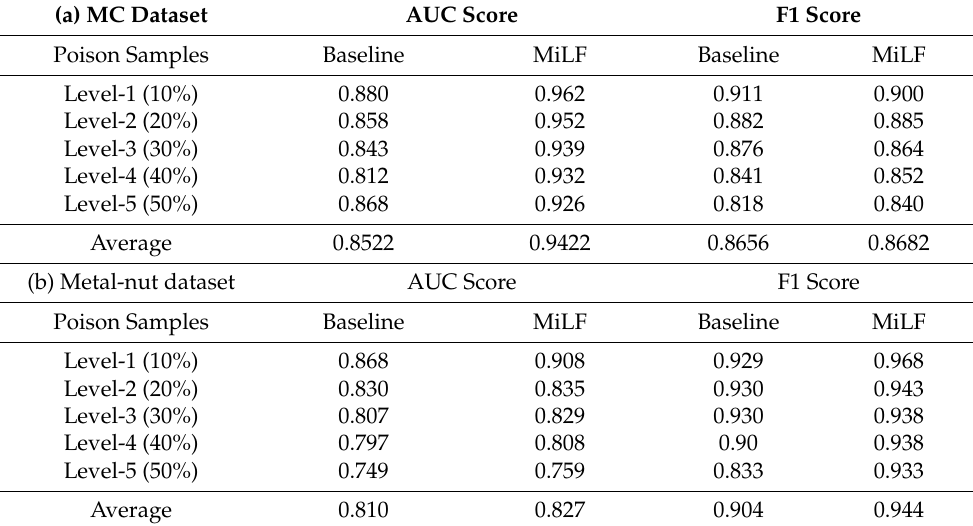
Table 4. Comparison results between the baseline and the baseline combined with our proposed HIT methods, as tested across various percentages of poison samples in testing